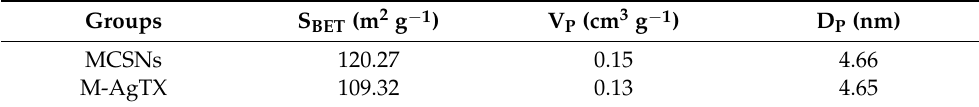
Table 1. The surface area (S BET ), pore volume (V P ), and mean pore size (D P ) of MCSNs and